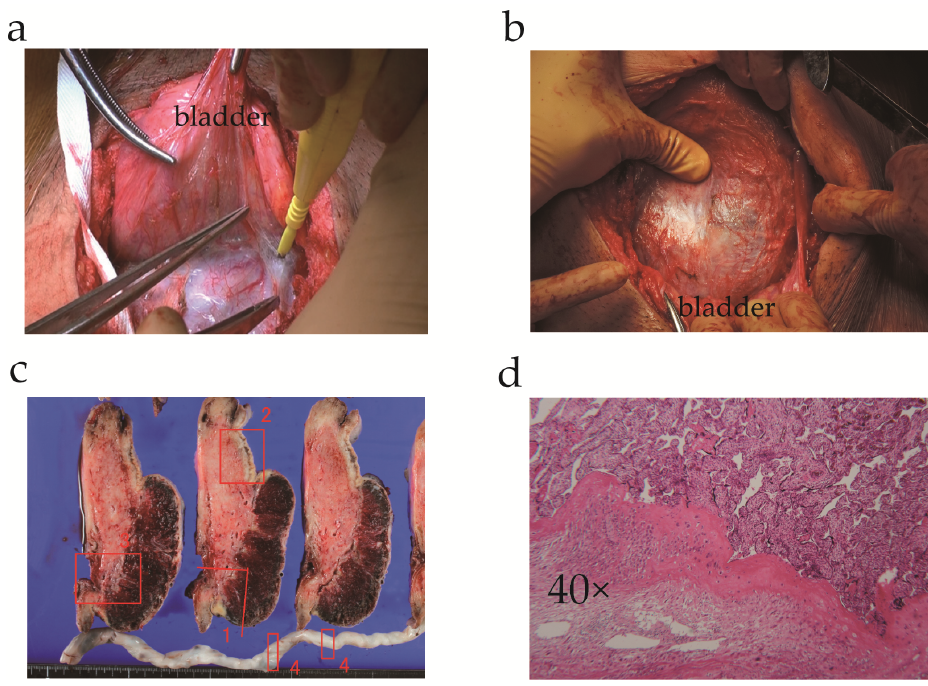
Figure 2. Intraoperative images and histopathological examination ( a , b ) Intraoperative picture revealing enlarged vessels and placenta through the thin anterior uterine wall after separating the bladder from the uterus; ( c ) The cut section of the hysterectomy specimen, showing placenta increta in section numbers 1 and 3 (number 2: uterine myometrium without placenta; number 4: cord vessels); ( d ) Histopathological image of uterine tissue revealing chorionic villi invading the myometrium.